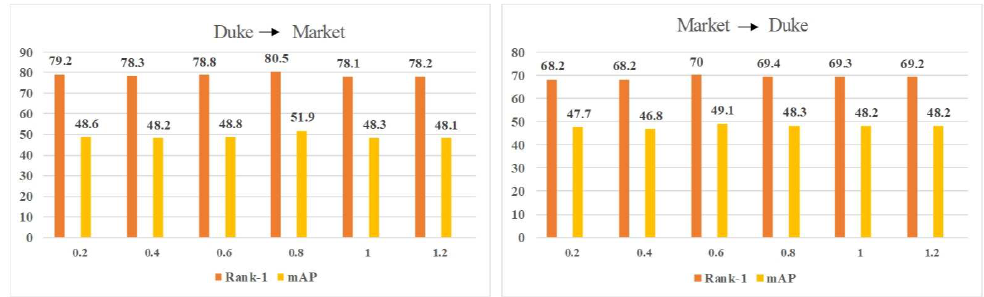
Figure 3. Evaluation with different values of the beta distribution parameter α . Scaling factor s : The scale factor s in Equation (3) is critical to the final performance.